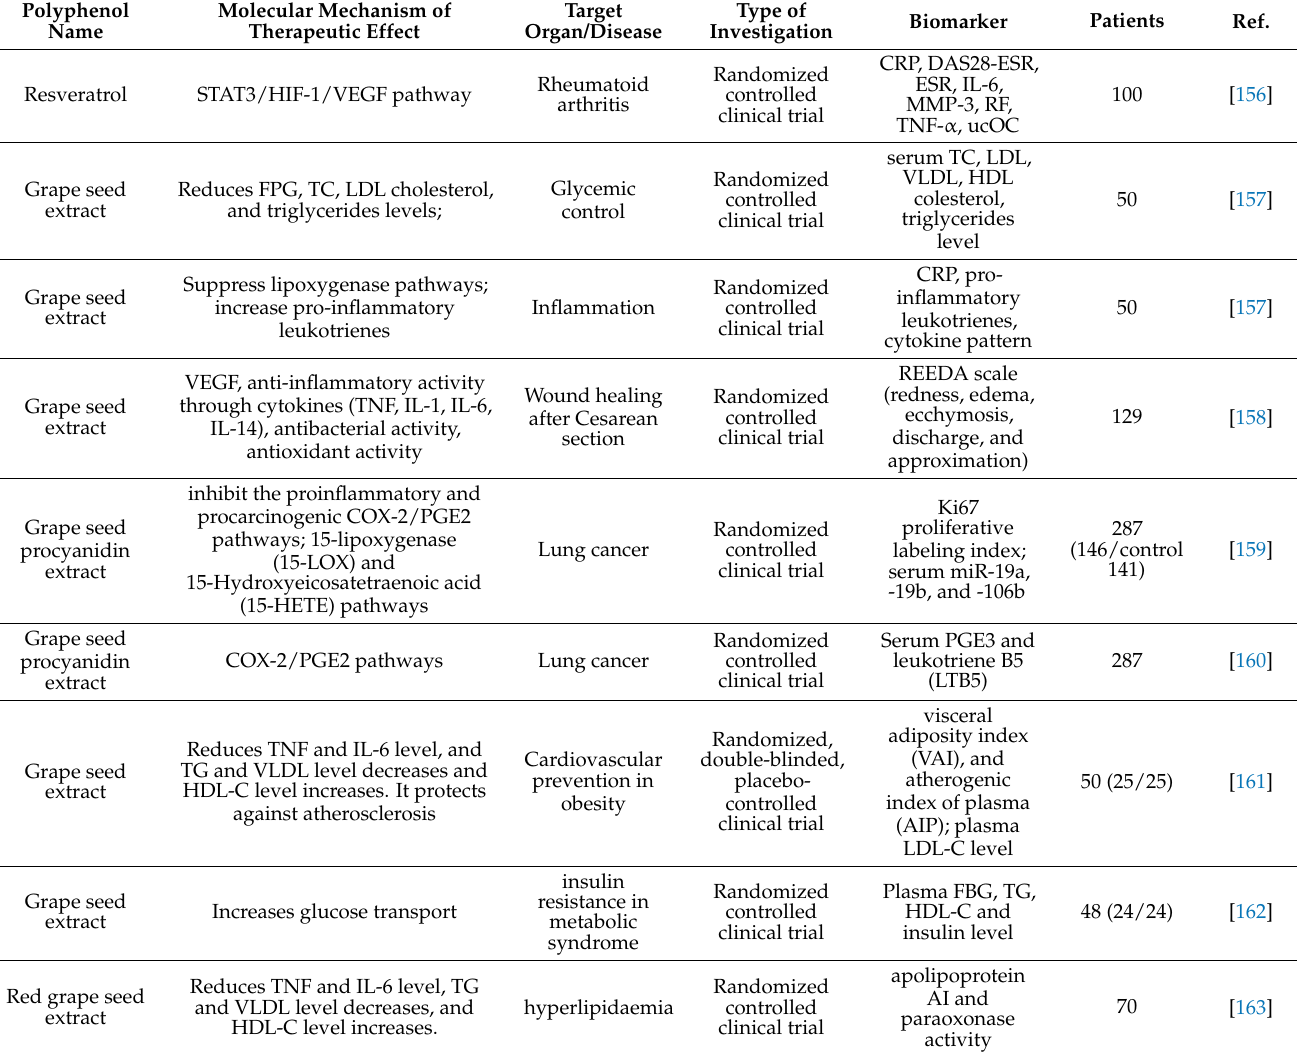
Table 16. Clinical investigation of grape seed extract polyphenols as therapeutics against the most common